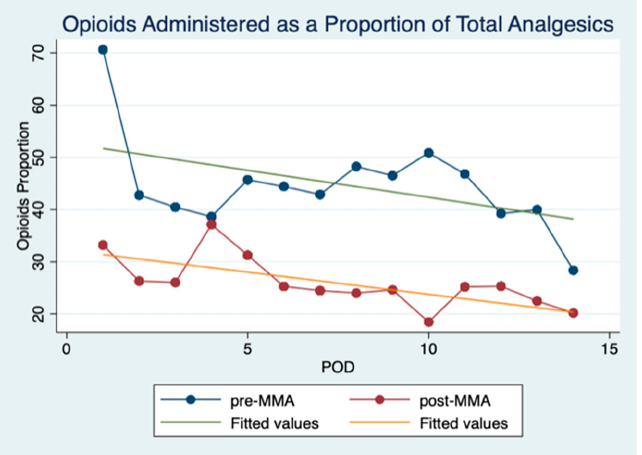
Figure 2. Opioids administered as a proportion of total analgesics . This figure shows opioids ad- ministered as a proportion of the total analgesics administered per POD (postoperative day).